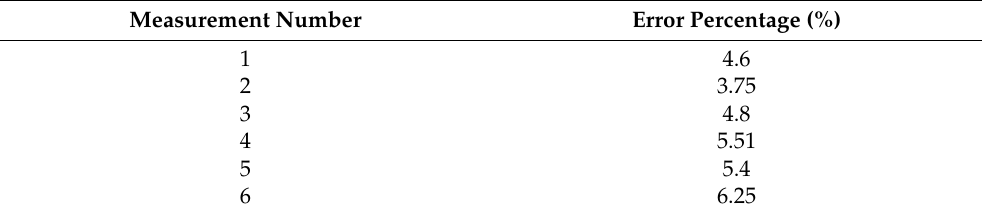
Table 7. Percentage error between proposed voltage ripples and ripples obtained in simulation. Measurement